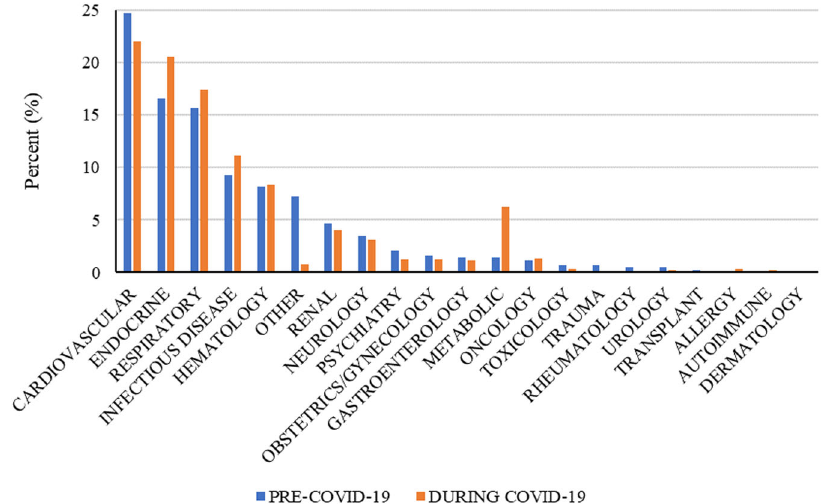
Fig. 4 During COVID-19, the metabolic and endocrine categories experienced the greatest percentage increase in healthcare professional attitudes towards using POCTs to monitor or manage